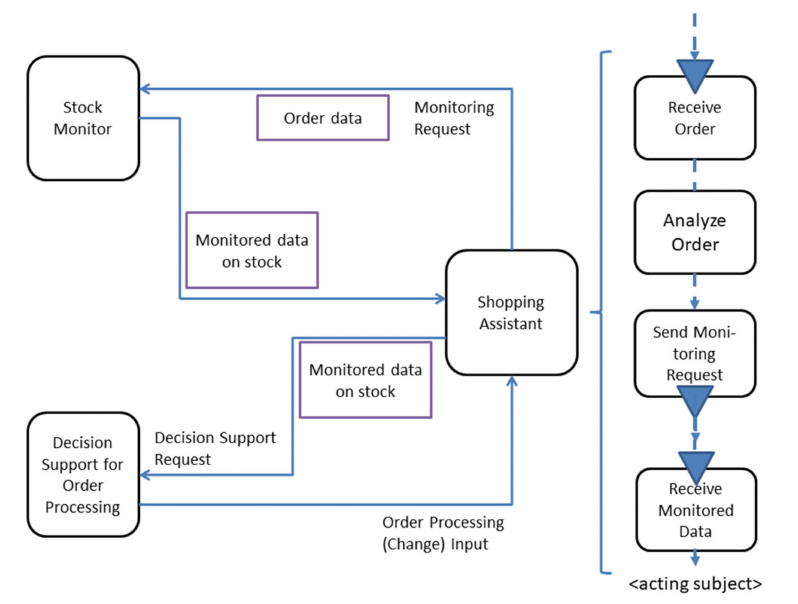
Figure 14. An <acting subject>, here: Shopping Assistant, can ask for monitoring to decide in a situation-sensitive